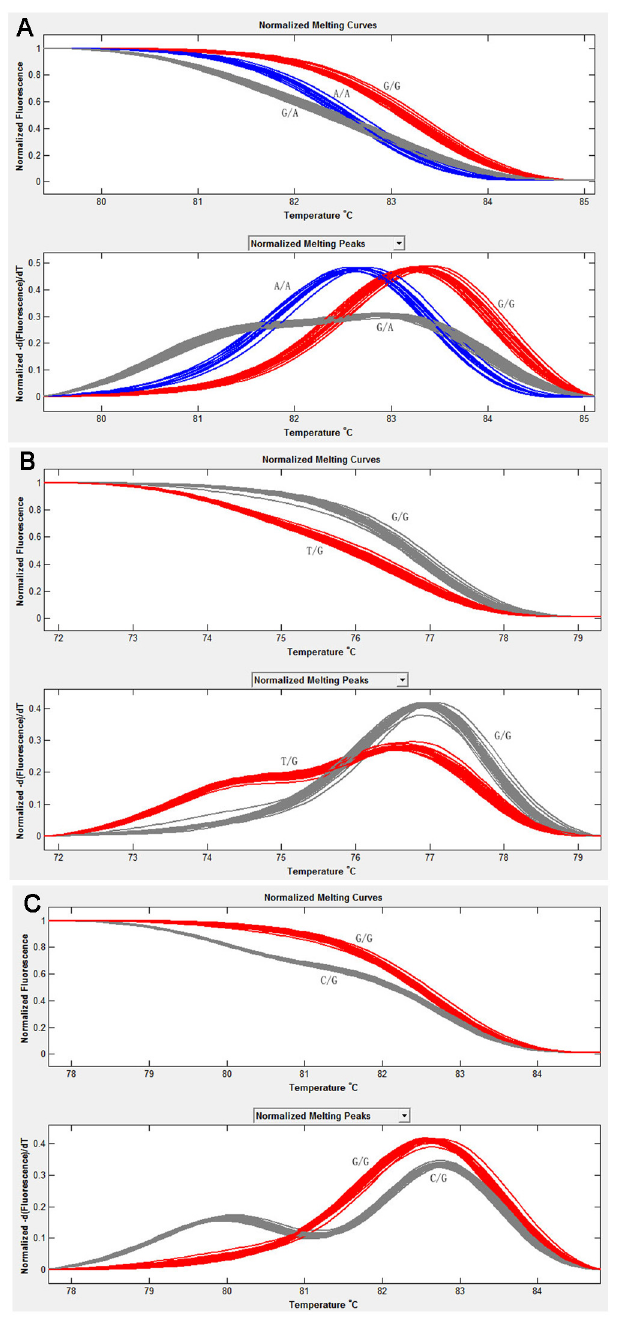
Fig 9. Genotyping result using HRM with small amplicon. (A) S10 genotyping; (B) S11 genotyping; (C) S14